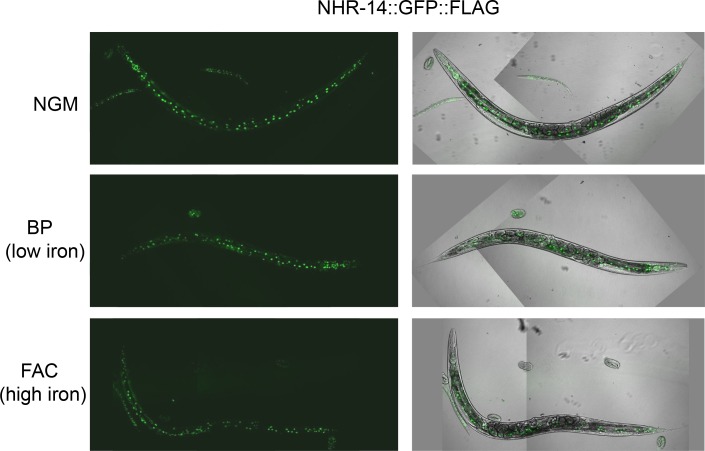
Iron does not affect the nuclear localization of NHR-14::GFP::FLAG.Representative images of worms expressing NHR-14::GFP::FLAG (Line 3) grown on NGM, NGM-25 µM BP (low iron) or NGM-FAC (high iron) plates (40x).